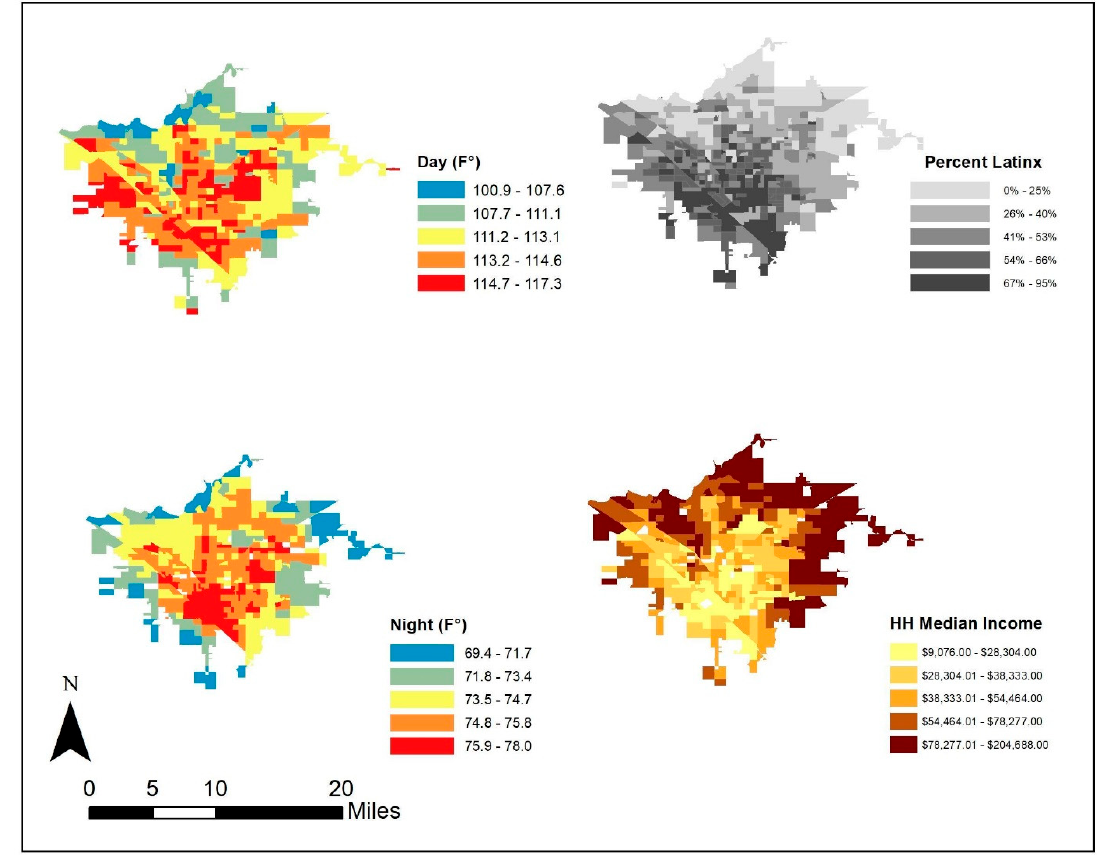
Figure 2. Fresno, California, located at 36.7° N and 119.8° W: surface temperature for an extreme heat day.